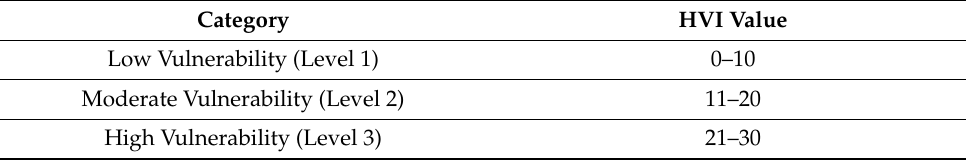
Table 5. HVI classical values (adapted from